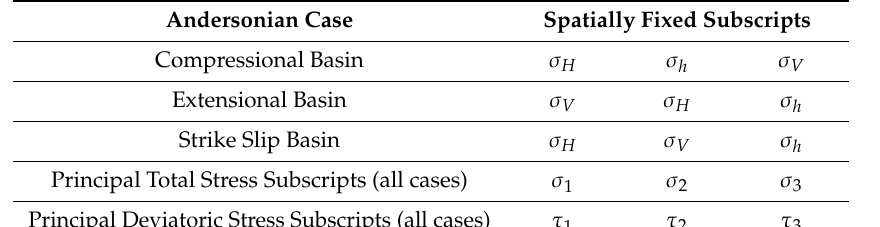
Table 3. Conversion of wellbore principal stress subscript system ( σ H , σ h , σ V ) to conventional principal stress system ( σ 1 , σ 2 , σ 3 ) depending on tectonic stress regime.